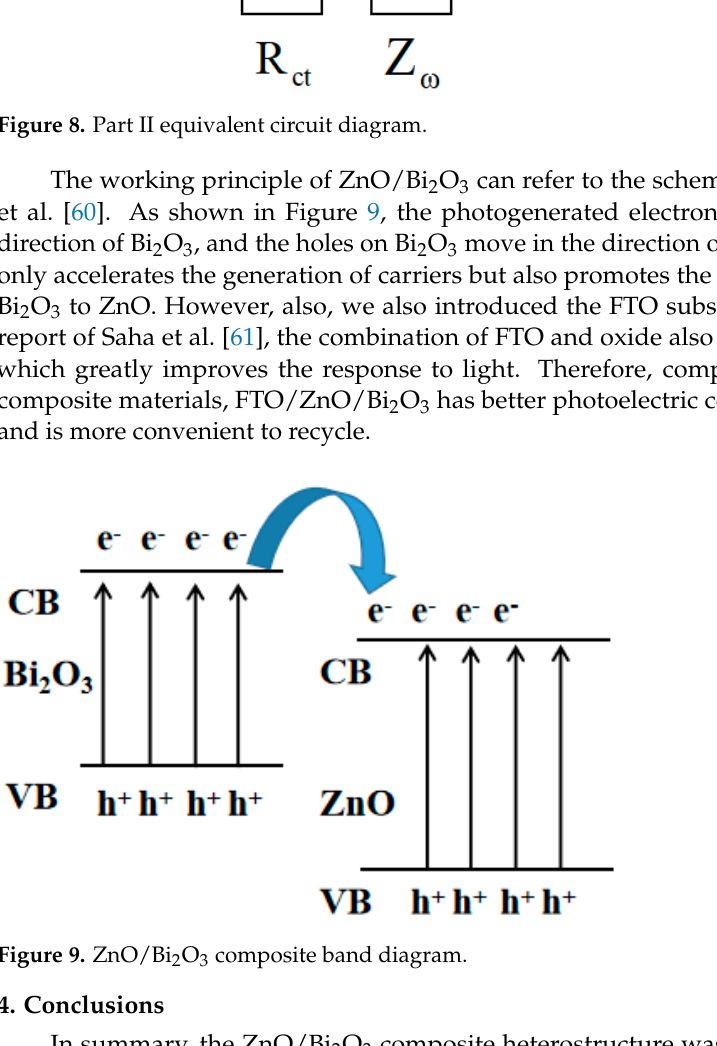
Figure 8. Part II equivalent circuit diagram.